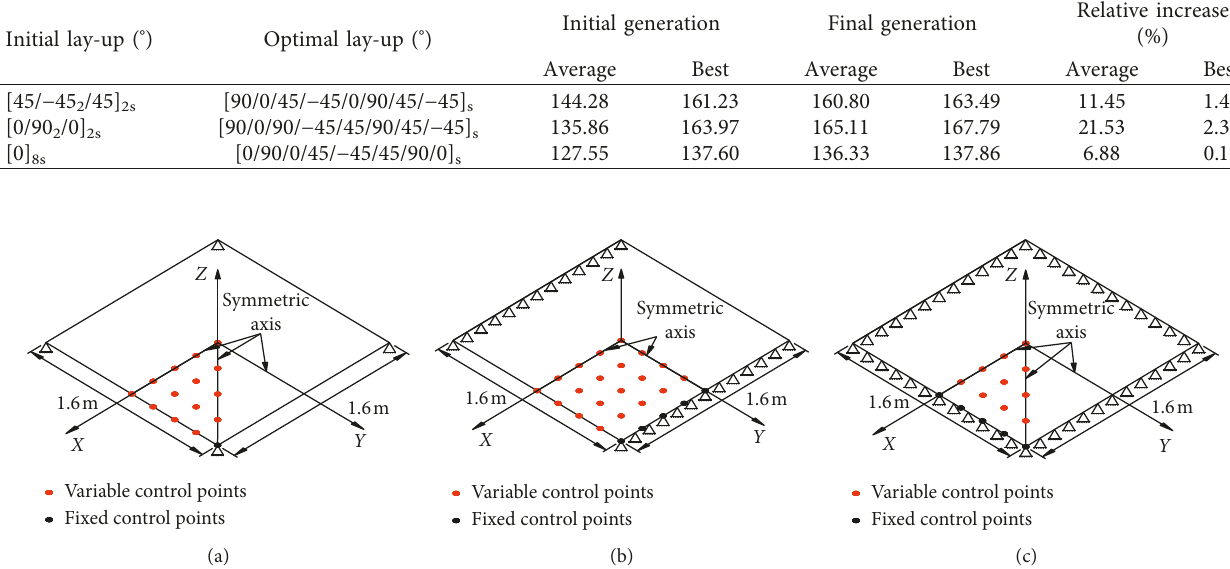
Figure 10: MIGA evolution of stacking sequence optimization for Shell 1 with different initial lay-ups. (a) Initial lay-up [45 ° / − 45 ° Initial lay-up [0 ° /90 ° 2 /0 ° ] 2s . (c) Initial lay-up [0 ° ] 8s